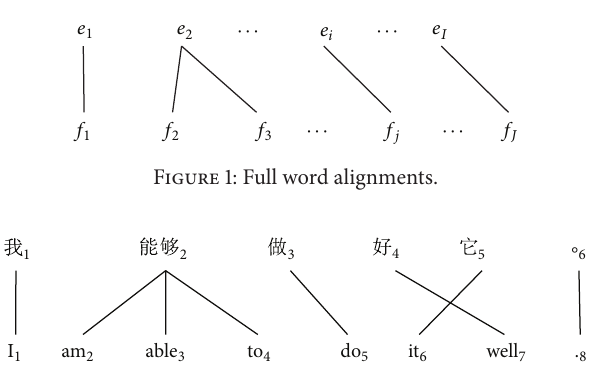
Figure 2: An example of nonmonotonic alignments where align- ment links are crossing between parallel sentences.